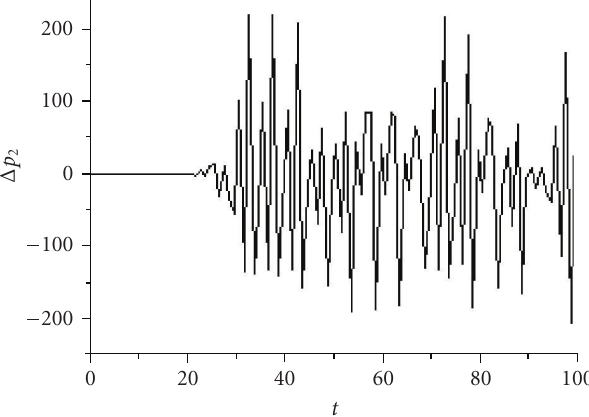
Figure 4.9 . Sensitivity to initial conditions of p 2